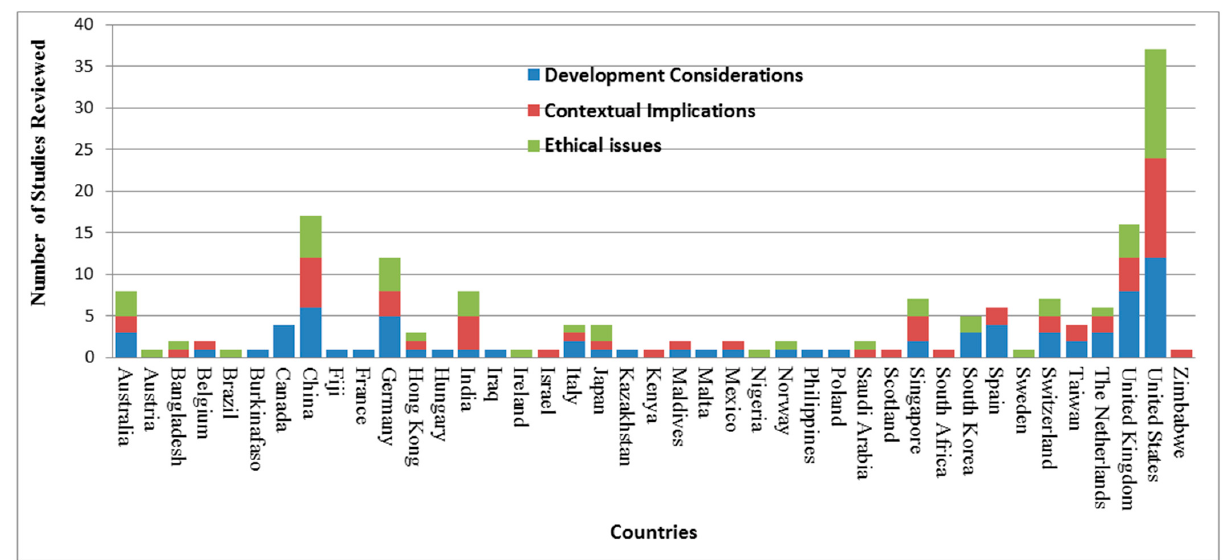
Figure 2. List of countries that contact tracing studies were reported for COVID-19.